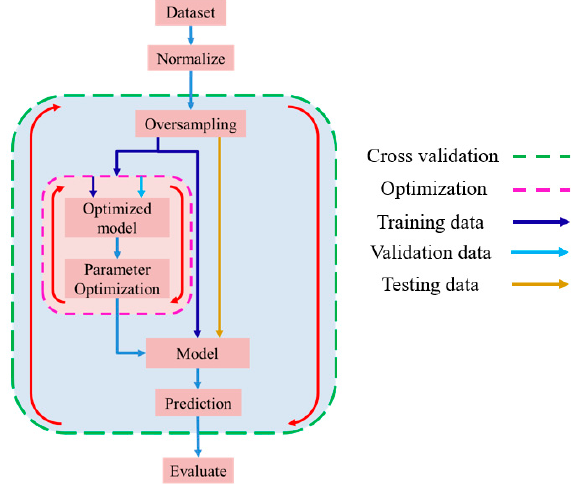
Figure 14. Optimized model training flowchart.